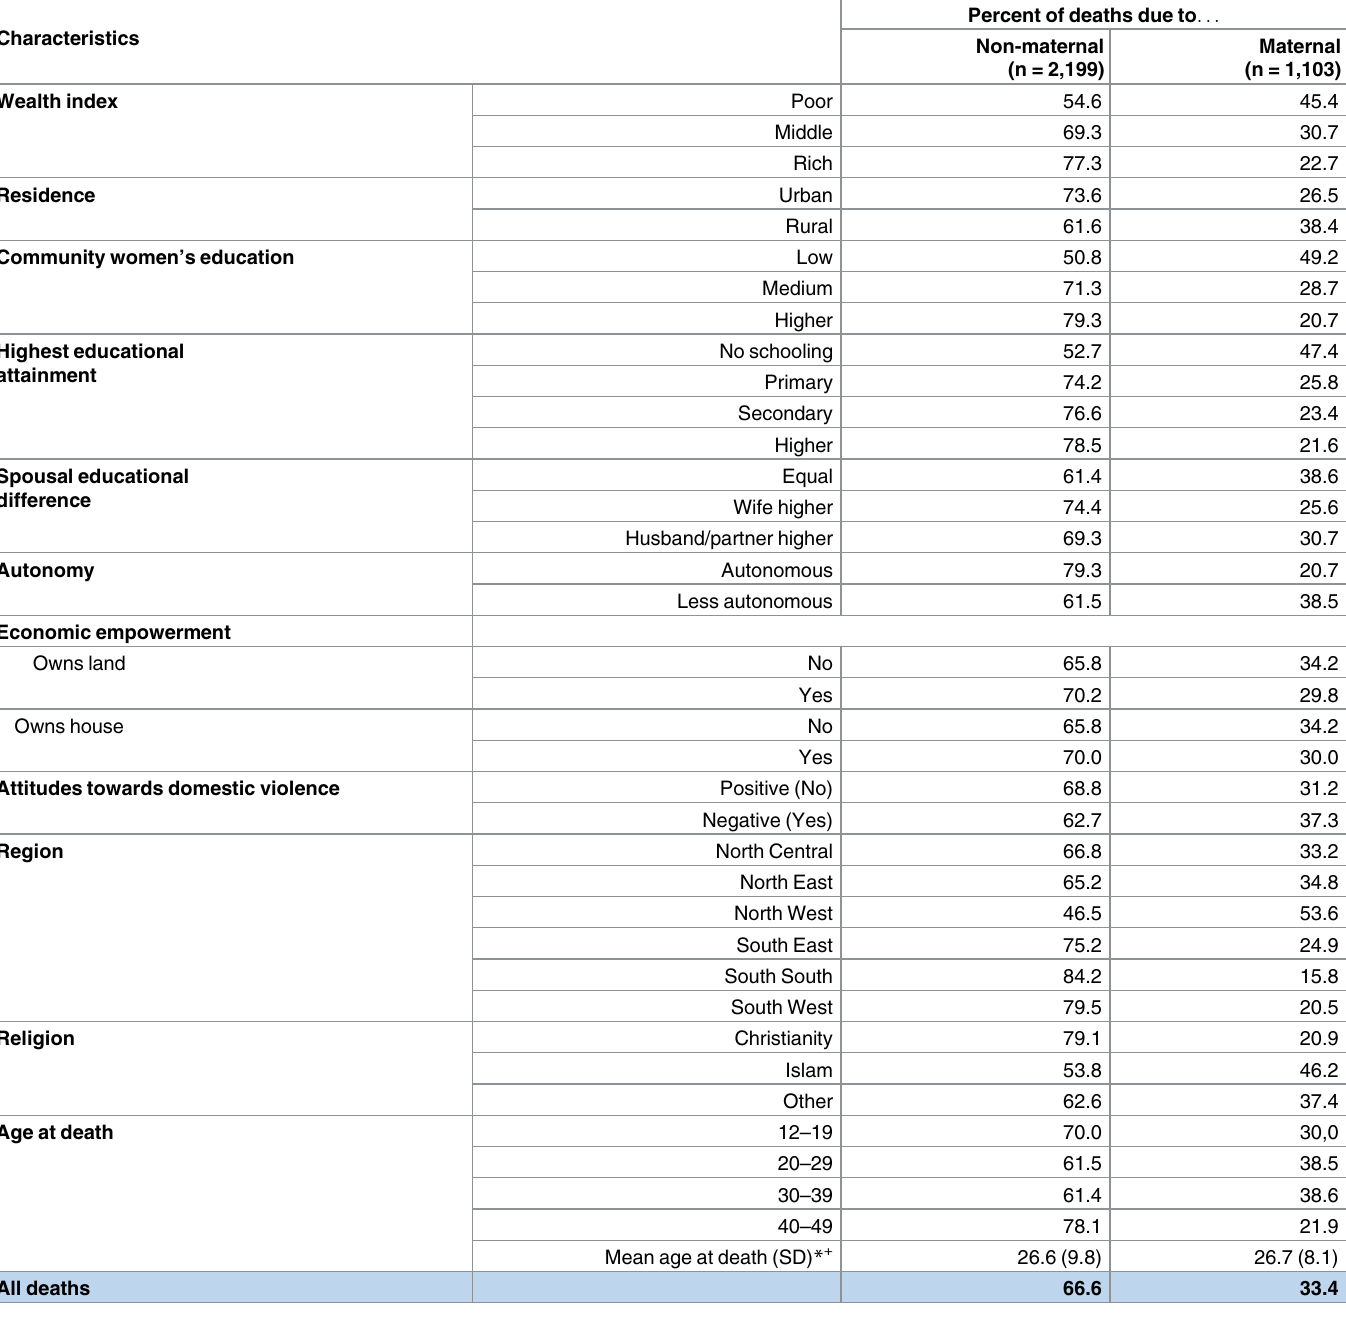
Table 2. Proportion of pregnancy-related deaths by selected characteristics identified by the direct sisterhood method, Nigeria Demographic and Health Survey 2013 (n = 3,302).